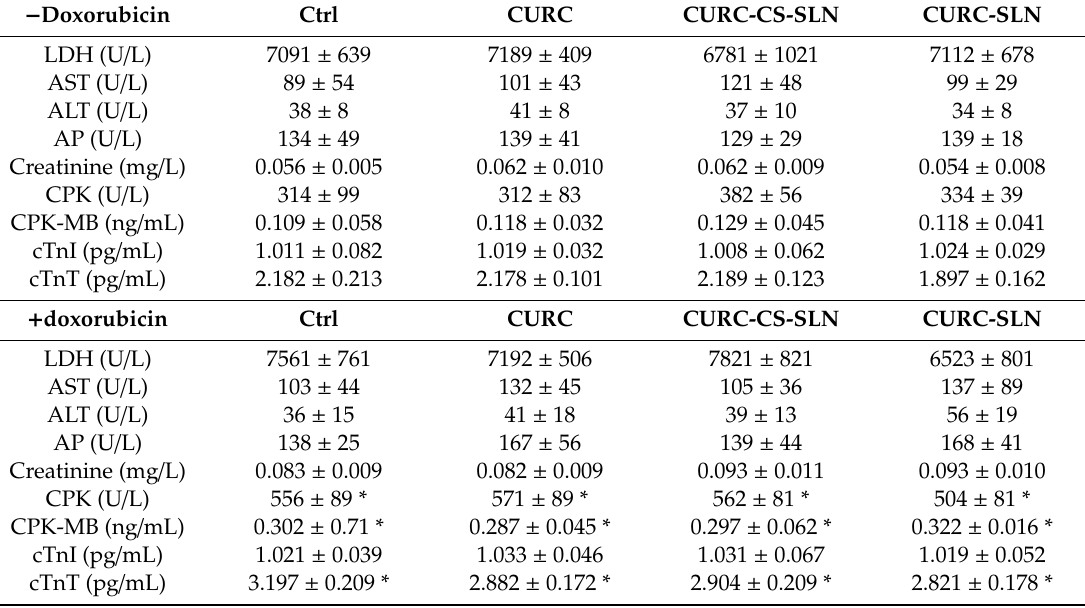
Table 2. Hematochemical parameters of the treated mice 1